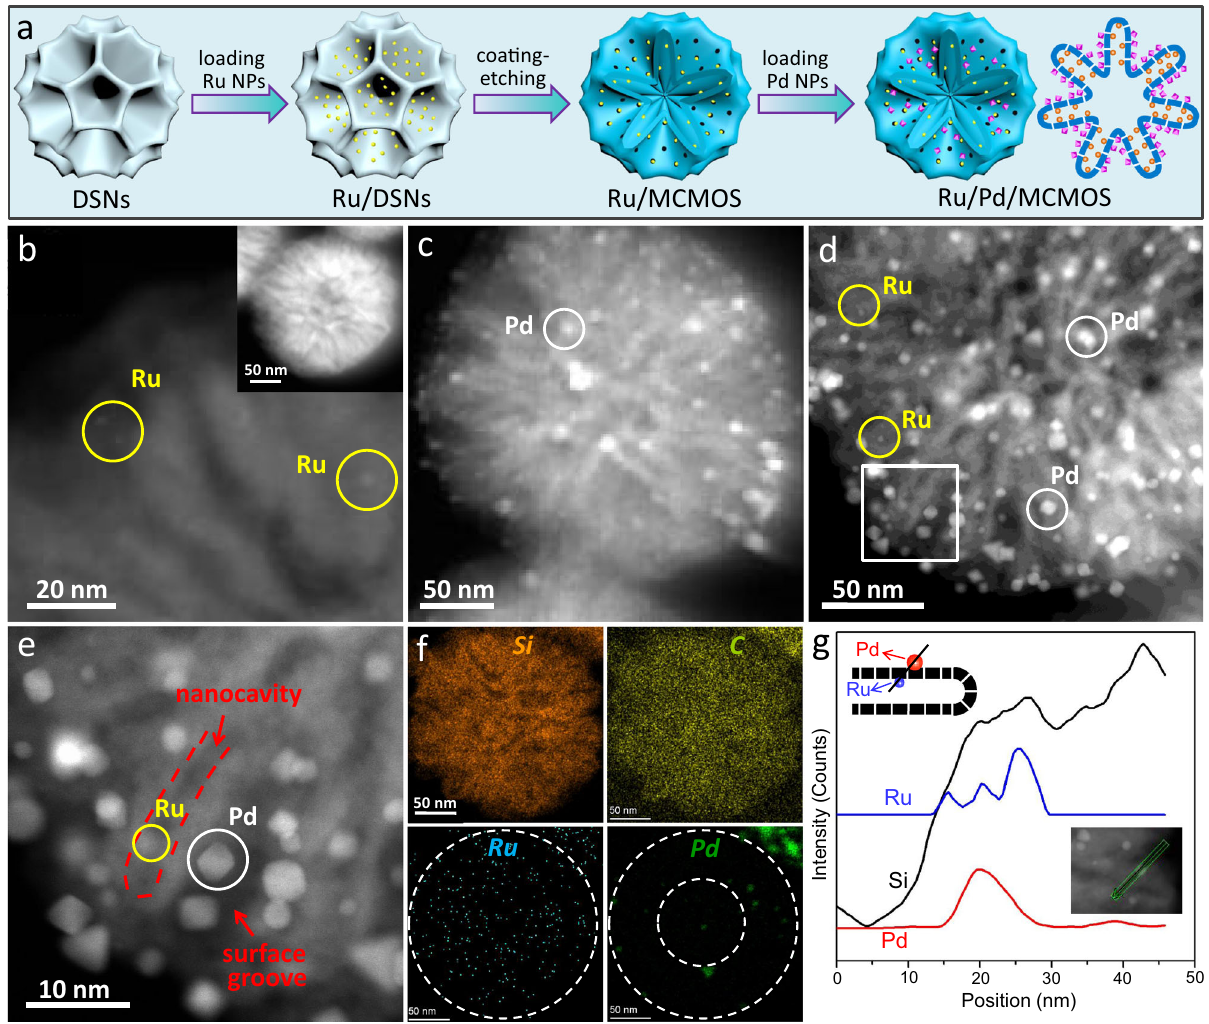
Fig. 2 Synthesis and characterization of the Ru/Pd/MCMOS cascade catalyst. a Schematic illustration for the fabrication of Ru/Pd/MCMOS. b – d HAADF-STEM images of Ru/MCMOS ( b ), Pd/MCMOS ( c ) and Ru/Pd/MCMOS ( d ). e – g High-magni fi cation HAADF-STEM image ( e ), EDX element mapping ( f ) and EDX line-scanning pro fi le ( g ) of